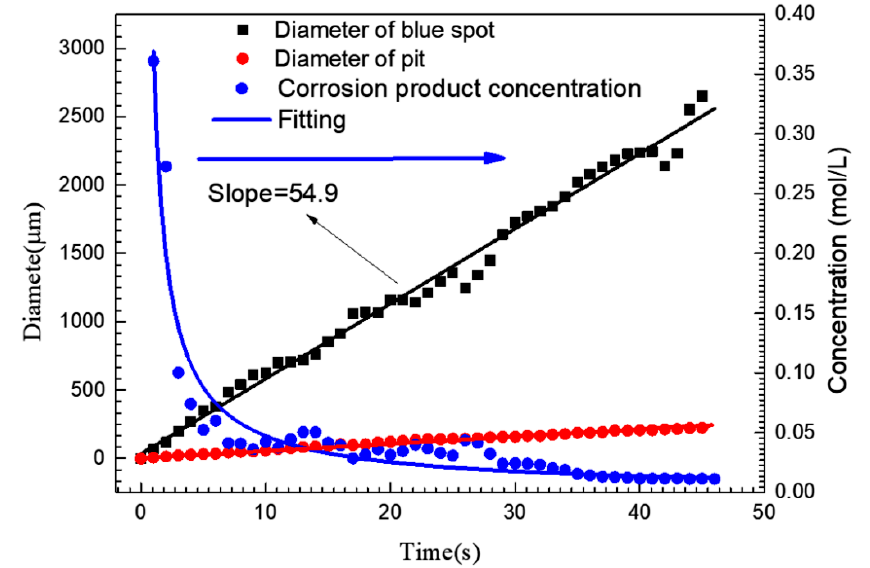
Figure 4. Variation curve of pit mouth diameter, blue spot diameter and the average corrosion product concentration in the blue spot area corresponding to a single pit corresponding to Figure 2( Ⅰ ).